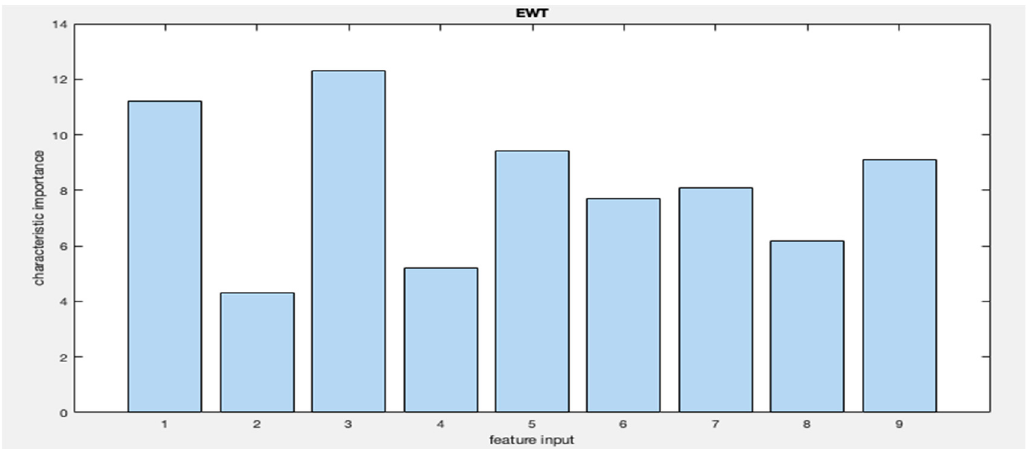
Figure 9. Importance of A1 signal by EWT characteristic of “Yangdong Line.”